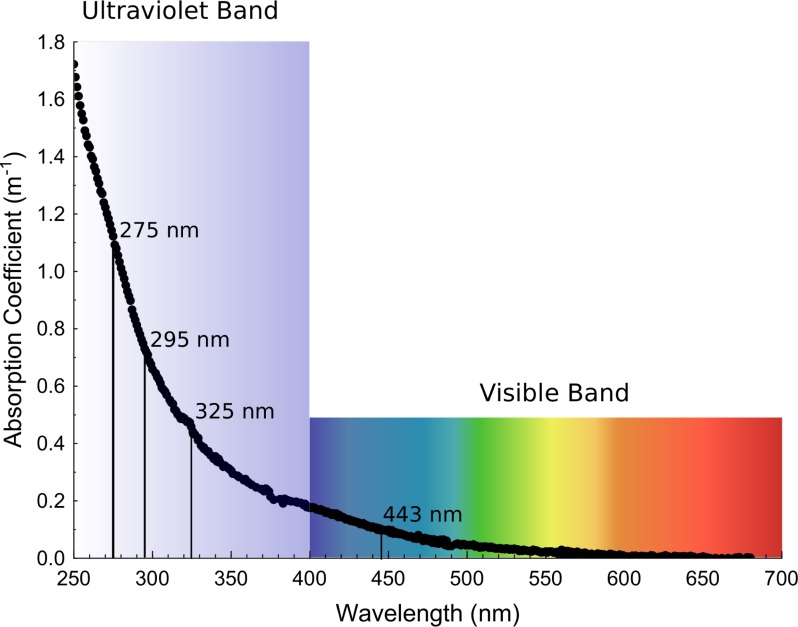
Exponential decay of absorption coefficients as wavelengths increase from the ultraviolet to the visible band.Example of a decay curve of the chromophoric dissolved organic matter in a sample taken on January 30th of 2014 from the big-volume tank that contains holothurians. The wavelengths selected for the calculation of the optical parameters used in this study are marked on the decay curve.